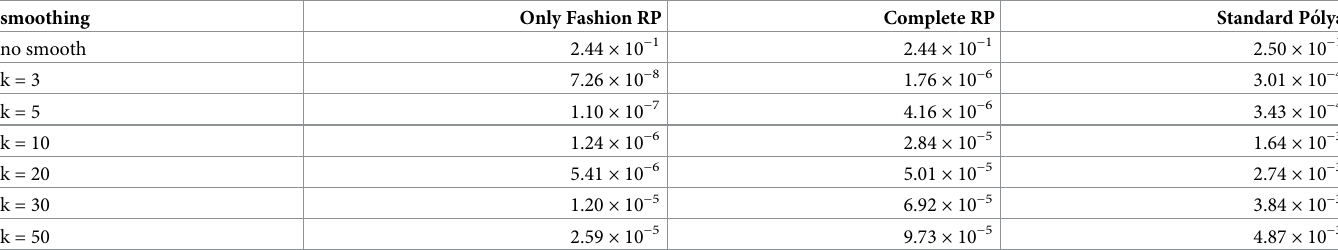
Table 16. “Migration” ( T = 0.35, entire, D = 3 0 , slots = days): MSE for different levels of smoothing. smoothing